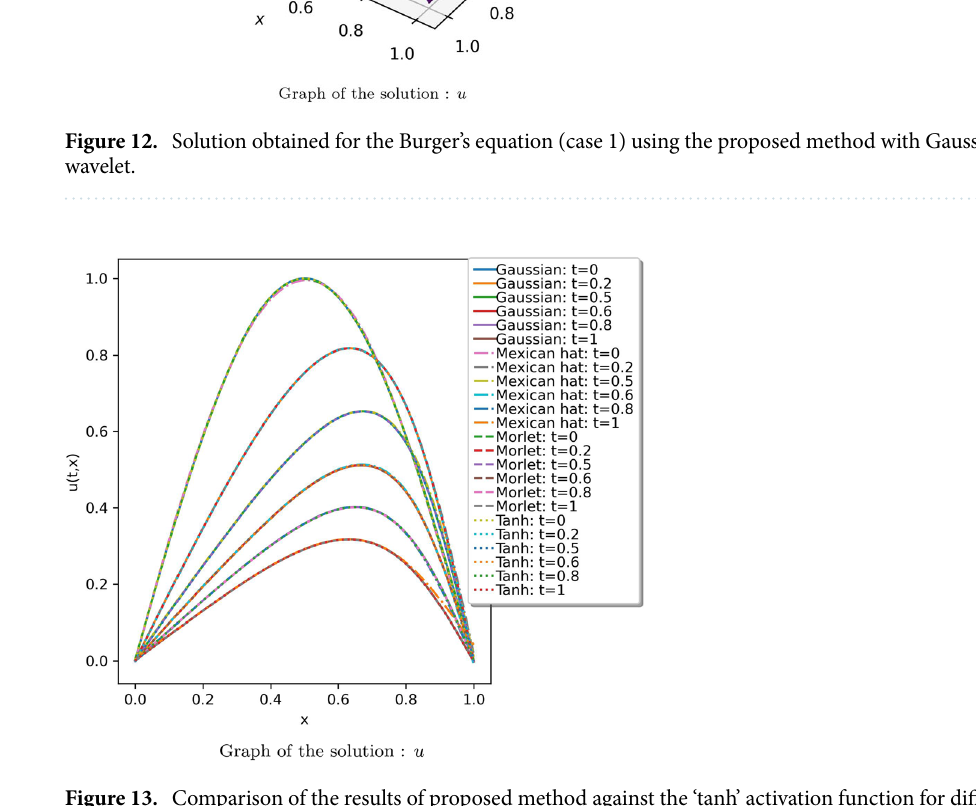
Figure 13. Comparison of the results of proposed method against the ‘tanh’ activation function for different values of